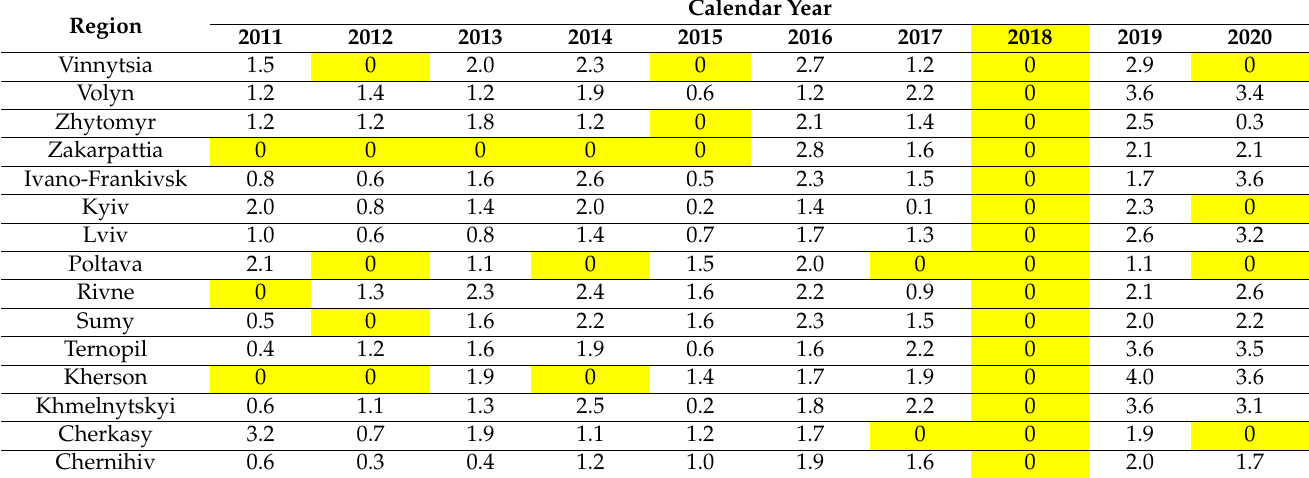
Table 2. Specific volumes of corn waste available for disposal in some regions of Ukraine,